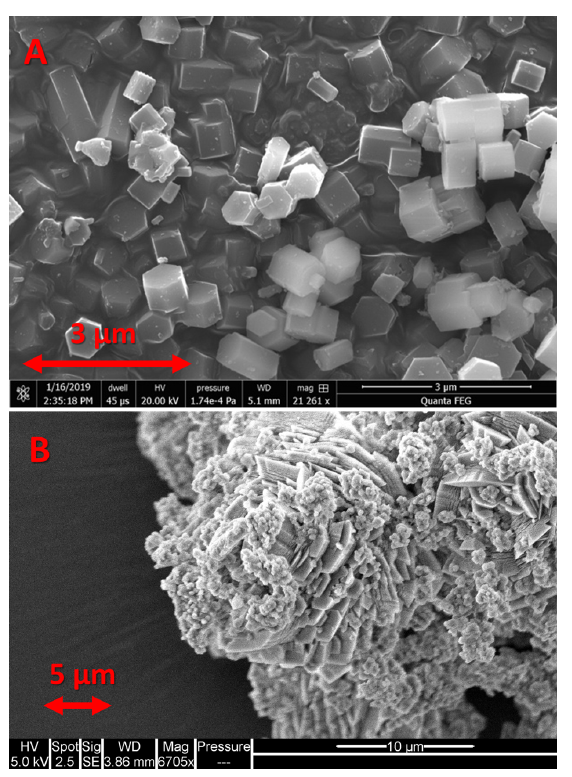
Figure 1: SEM images of microporous MP-SAPO-5 (A) and hierar- chical HP-SAPO-5